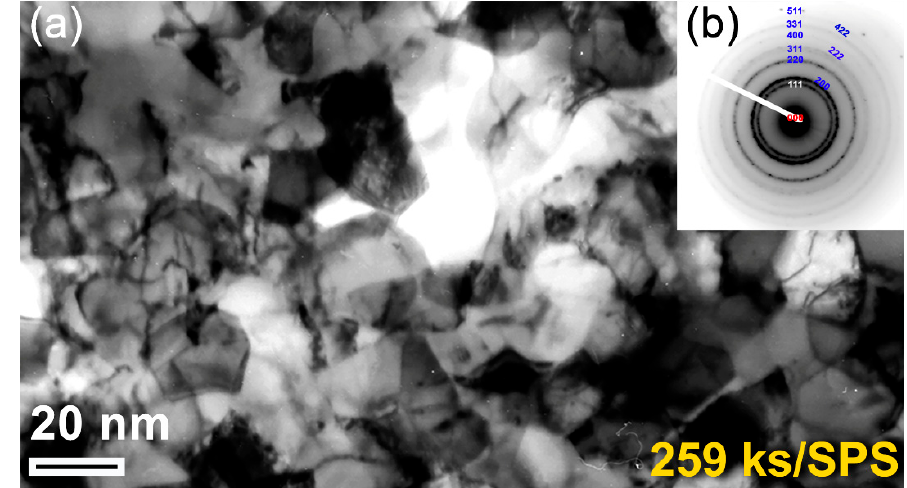
Figure 6. ( a ) Bright field image (BFI) of the planer view for the as-consolidated fcc-ZrN metastable phase that was obtained after 259 ks of RBM and then SPS, and ( b ) the related SADP, which was taken from the middle zone of ( a ).